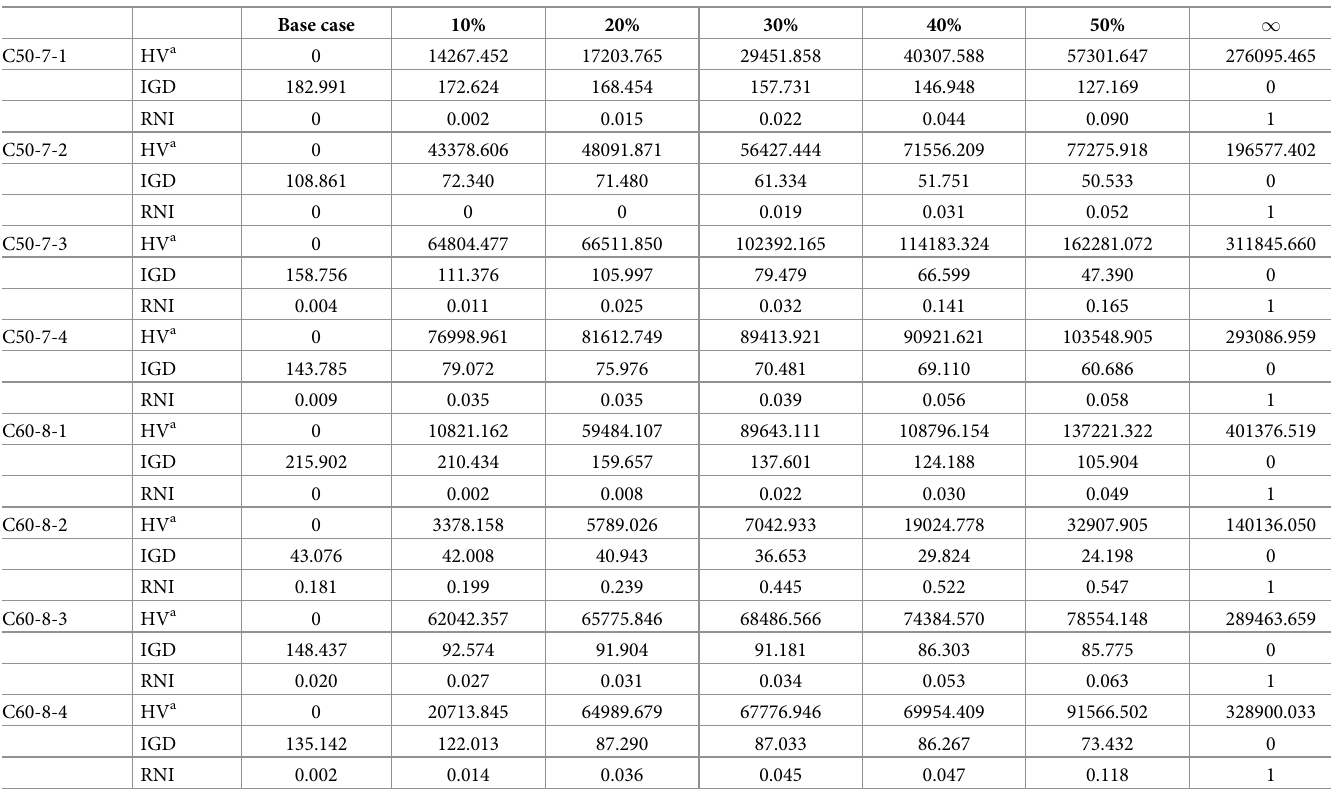
Table 7. Performance indicators of seven variants of depot capacity.